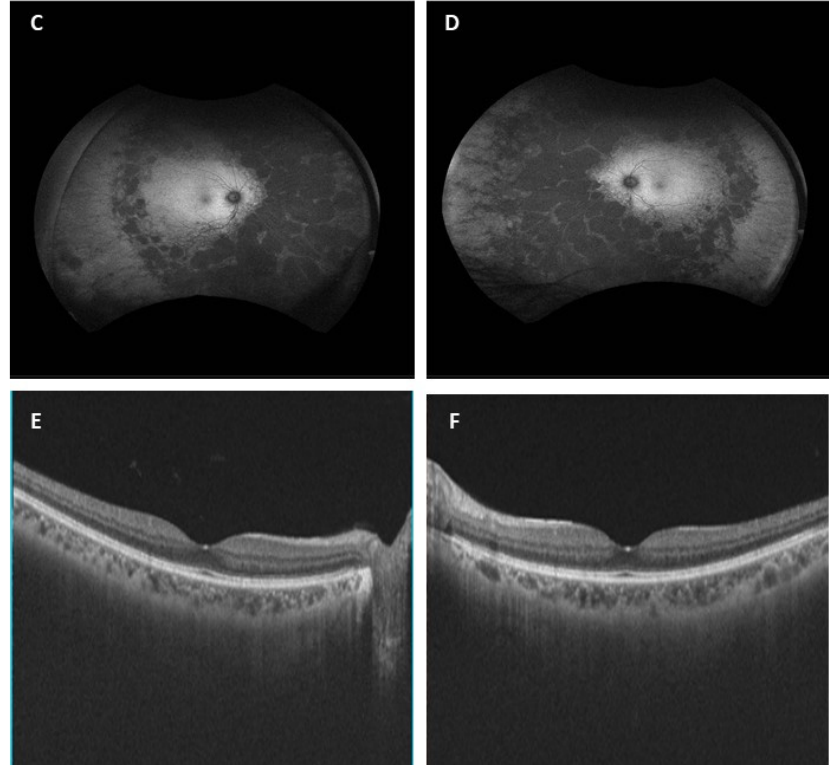
Figure 1. Ultra-widefield fundus photographs of the right ( A ) and left ( B ) eye performed using the optos camera showed well-delineated concentrical mid peripheral patches of chorioretinal atrophy sparing the macula in both eyes. Ultra-widefield short-wavelength fundus autofluorescence illustrated mid-peripheral round well-demarcated patchy loss of autofluorescence in both eyes ( C , D ). Macular Optical coherence tomography (OCT) photos showed no macular abnormality in either eye ( E , F ).